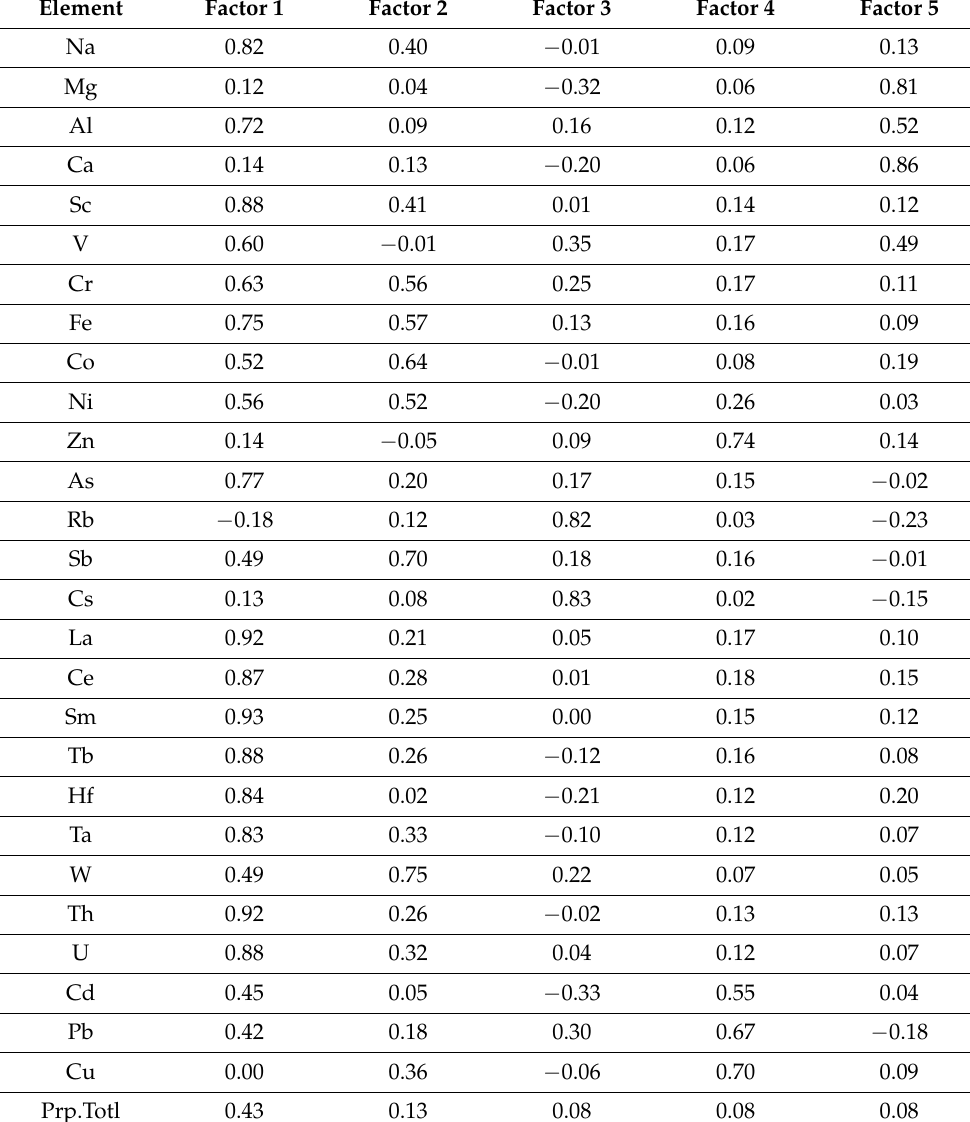
Table 4. Matrix of rotated factor